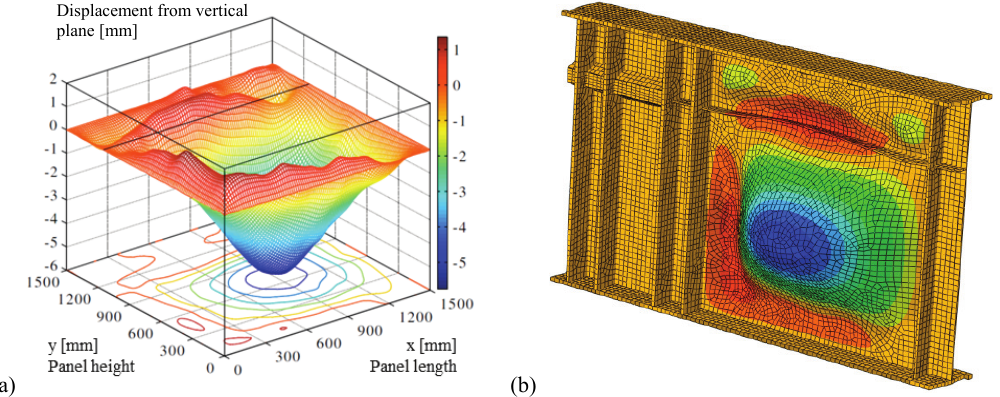
Fig. 7. Deformations of panel S0: